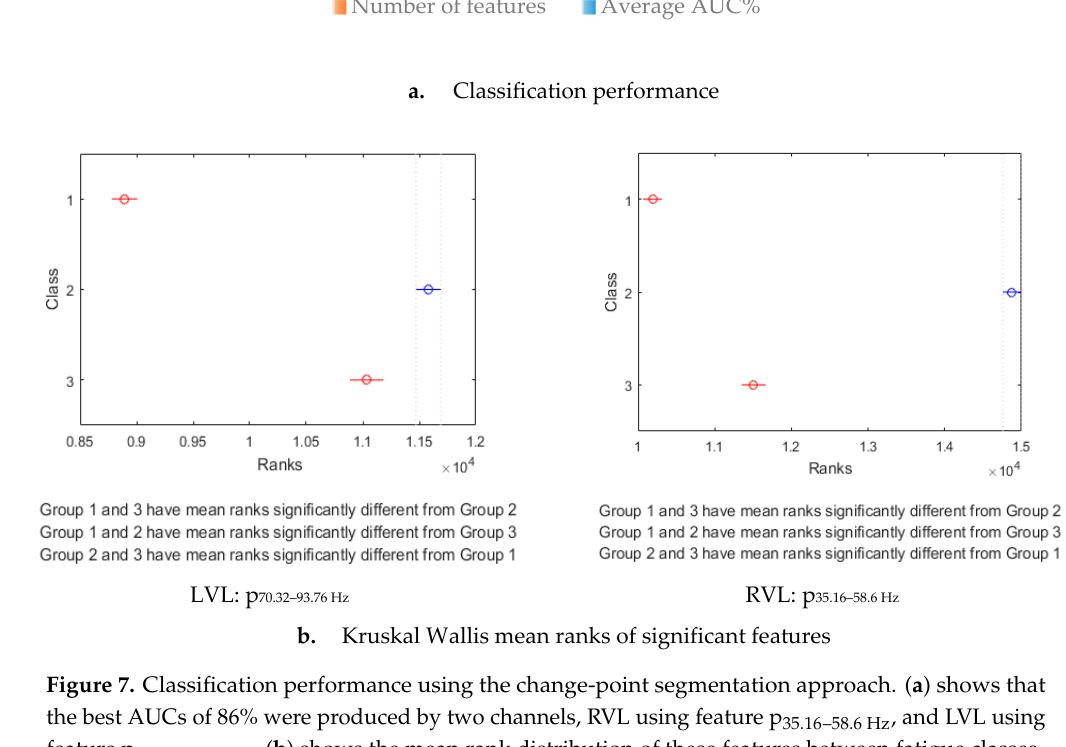
Figure 7. Classification performance using the change-point segmentation approach. ( a ) shows that the best AUCs of 86% were produced by two channels, RVL using feature p 35.16–58.6 Hz , and LVL using feature p 70.32–93.76 Hz . ( b ) shows the mean rank distribution of these features between fatigue classes.